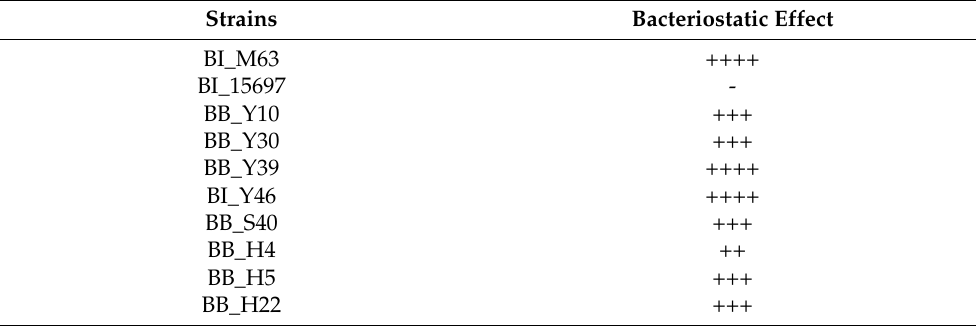
Table 3. Inhibitory effect of bifidobacterial supernatant on Escherichia coli ATCC 25922.